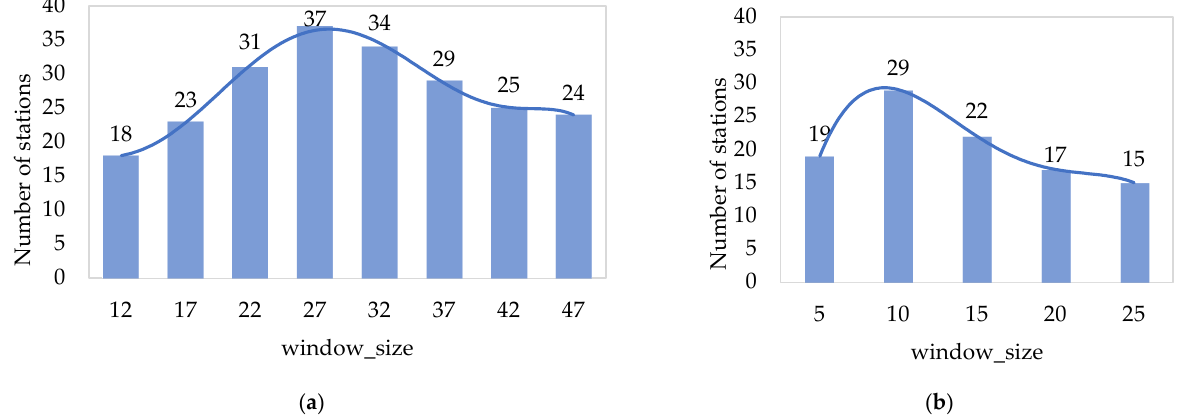
Figure 9. ( a ) Effect of window size for electromagnetic signals on prediction model. ( b ) Effect of time window size for geoacoustic signals on prediction model.